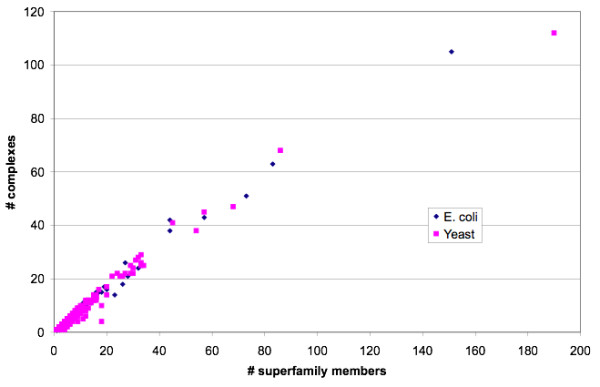
Distribution of CATH superfamilies in MCL-GO complexes. This figure shows the number of CATH superfamily members versus number of complexes containing members of that superfamily for E. coli and yeast MCL-GO complexes.